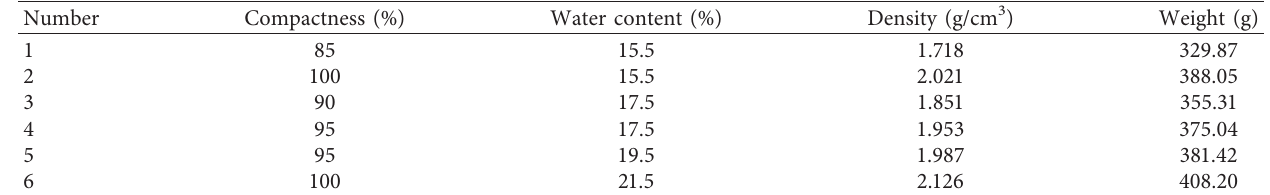
Table 3: The parameters of soil